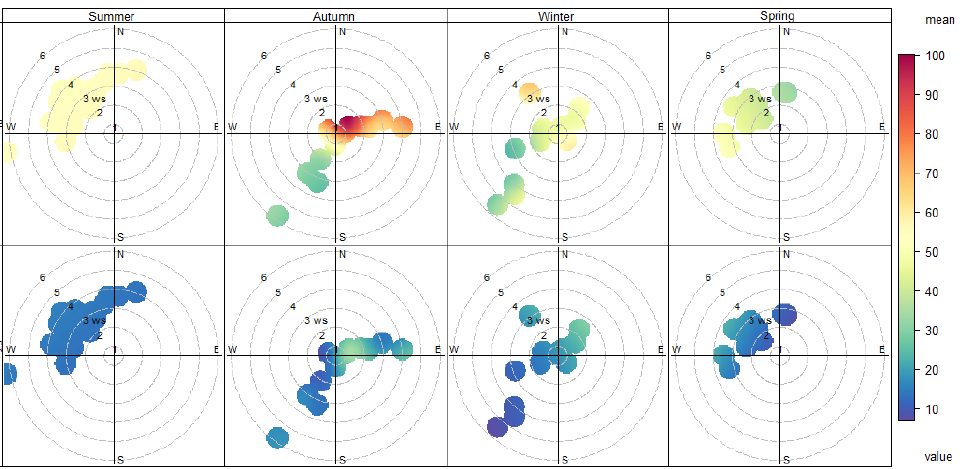
Figure 6. Polar plots of PM 10 and PM 2.5 concentrations for four seasons (spring, winter, summer, and autumn) in the city of Kenitra. The average PM concentration (µg/m 3 ) is coded according to the color scale shown on the right. The dashed circular grey lines show the wind speed scale.